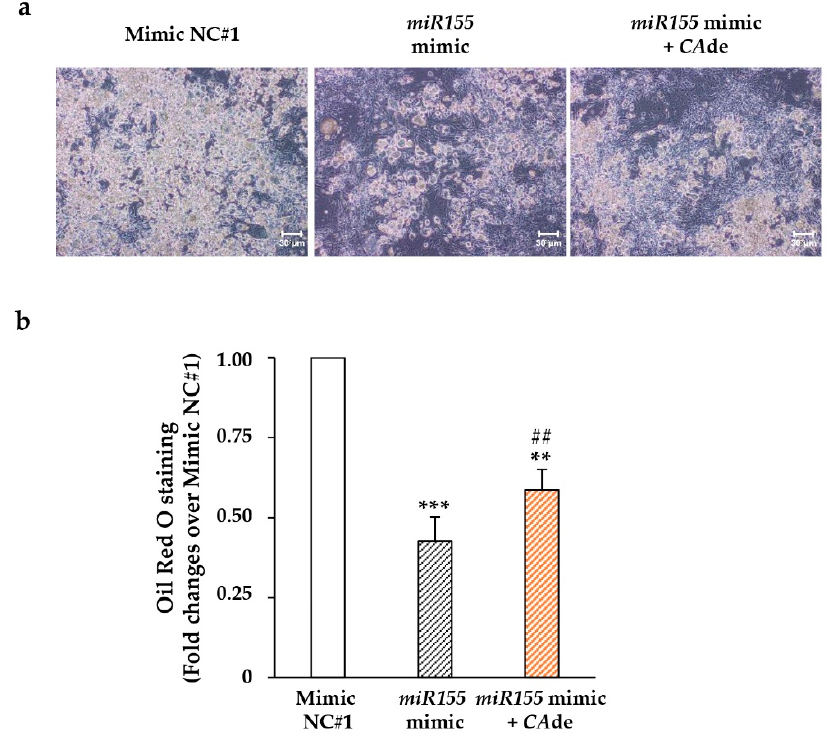
Figure 3. E ff ect of CA de on adipocyte di ff erentiation and lipid accumulation of 3T3-L1 adipocytes over-overexpressing miR-155 . 3T3-L1 pre-adipocytes were transfected with the mimic negative control (NC) #1 or with the miR-155 mimic, and were cultured to reach adipocyte di ff erentiation for 8 days with AS. Cells transfected with the miR-155 mimic were also di ff erentiated with AS supplemented with CA de (100 µ g / mL). ( a ) Representative microphotographs of adipocytes transfected with mimic negative control (NC) #1 or with the miR-155 mimic ± CA de are shown (X10 magnifications); scale bars, 30 µ m. ( b ) Oil-Red O staining of adipocytes transfected with mimic negative control (NC) #1, or with the miR-155 mimic ± CA de. Values are mean ± SEM of determinations from three independent experiments. Statistical significances among groups were tested by one-way ANOVA followed by Bonferroni correction post-hoc test (** p < 0.01, and *** p < 0.001 vs. mimic negative control (NC) #1; ## p < 0.01, miR-155 mimic + CA de vs. miR-155 mimic).